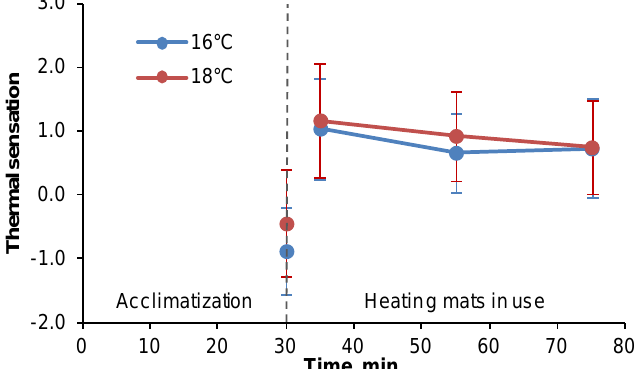
Figure 2. Average general thermal sensation and standard deviation during exposures at 16 and 18 °C. Thermal sensation: − 2—cool, − 1—slightly cool, 0—neutral, 1—slightly warm, 2—warm, 3—hot.